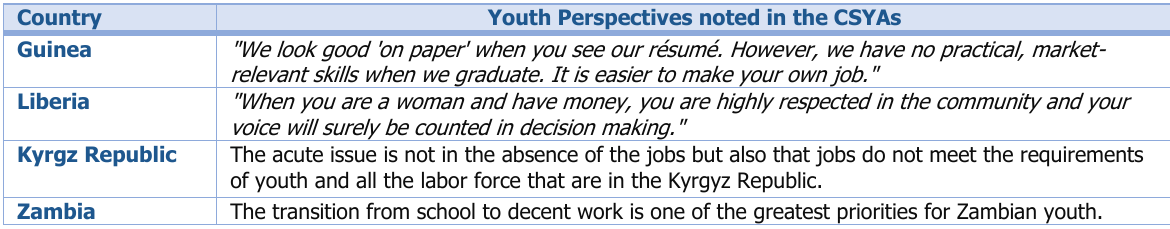
Table 4. Youth Perspectives on Workforce and Livelihood